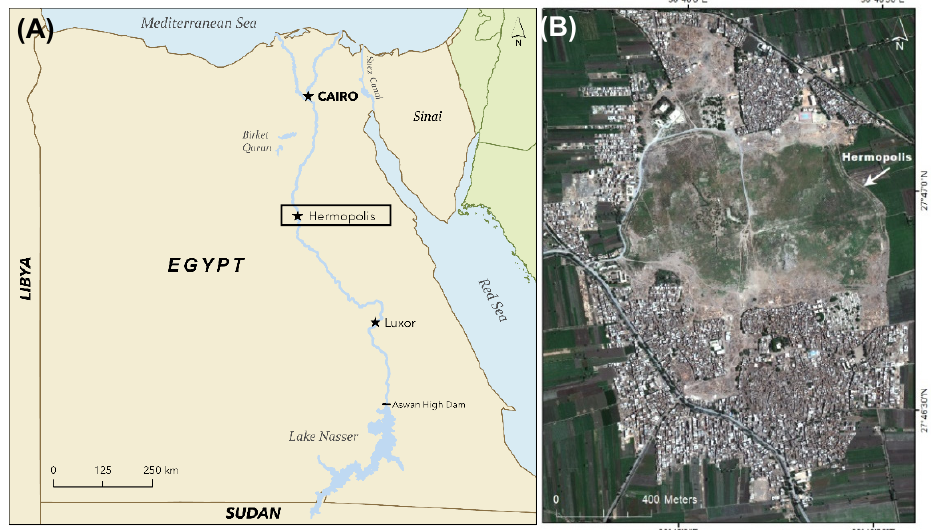
Figure 1. Simplified map of Egypt showing the location of the study site, highlighted by the black box ( A ). WorldView-3 satellite imagery displayed in true color for the archaeological area of Hermopolis. The image shows the archaeological site delimited by urban clusters and agricultural fields ( B